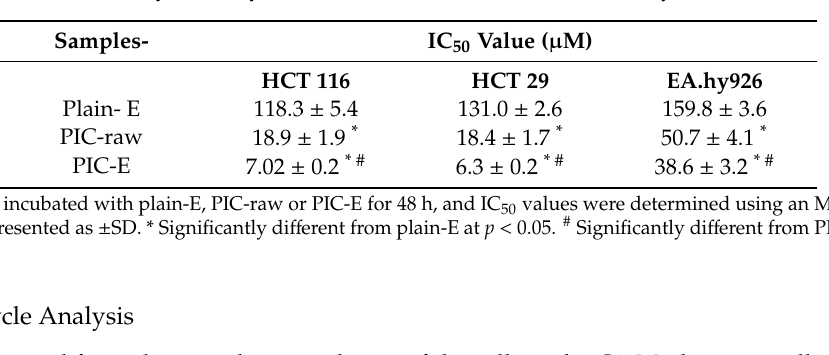
Figure 5. In vitro release profile of PIC-E in phosphate-buffered saline (pH 7.4, 0.1 M) containing Tween 80 (0.1%) at 37 ± 0.5 ° C .